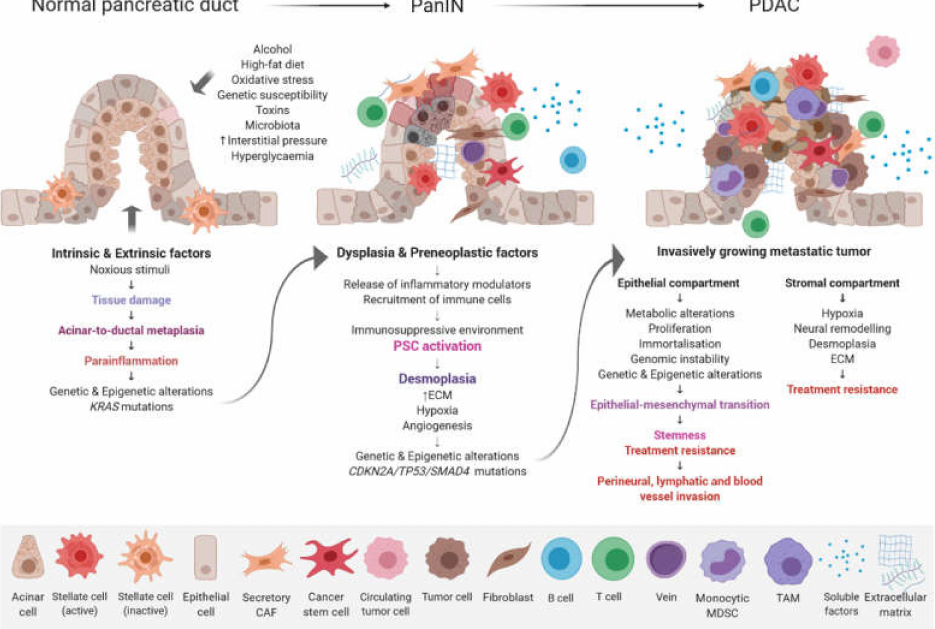
Figure 1. Progression model of PDAC. The stepwise accumulation of morphologic, histopathologic, genetic, and epigenetic changes are accompanied by immune cell infiltration and a desmoplastic stromal reaction. Abbreviations: CAF, cancer-associated fibroblast; ECM, extracellular matrix; MDSC, myeloid-derived suppressor cell; PSC, pancreatic stellate cell; TAM, tumor-associated